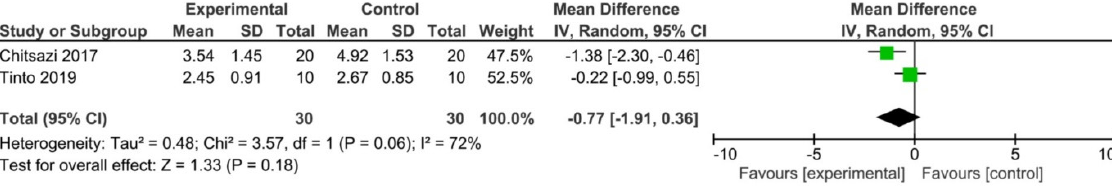
Figure 2. Meta-analysis summarizing the difference in pocket depth between the control (NSPT) and the experimental group (systemic melatonin application with NSPT).